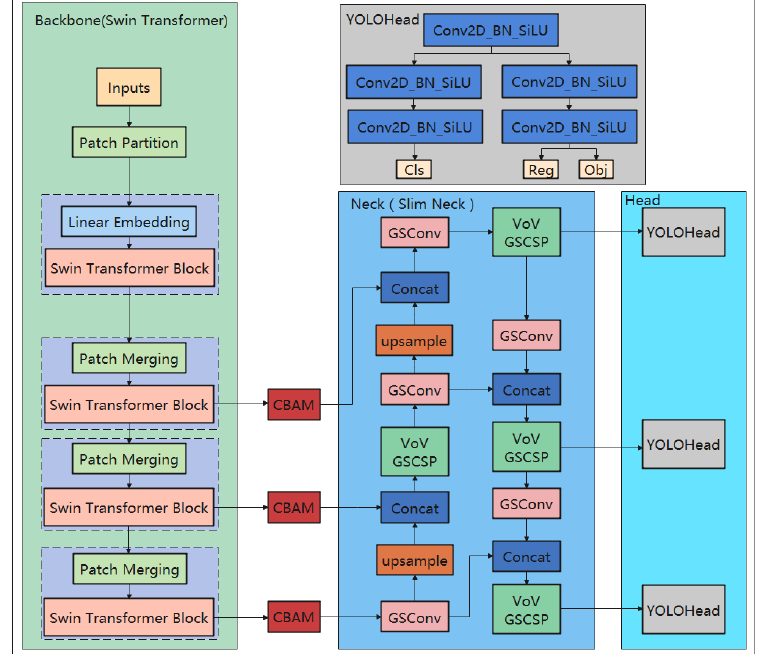
Figure 2. Improved YOLOX network structure.